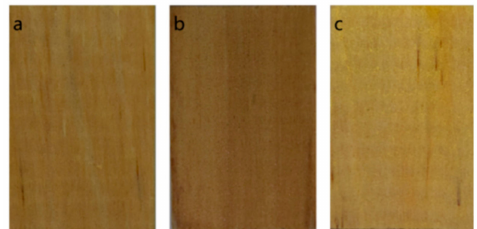
Figure 4. Images of surfaces of RP. ( a ) untreated sample, ( b ) sodium bicarbonate-treated sample, ( c ) ozone-treated